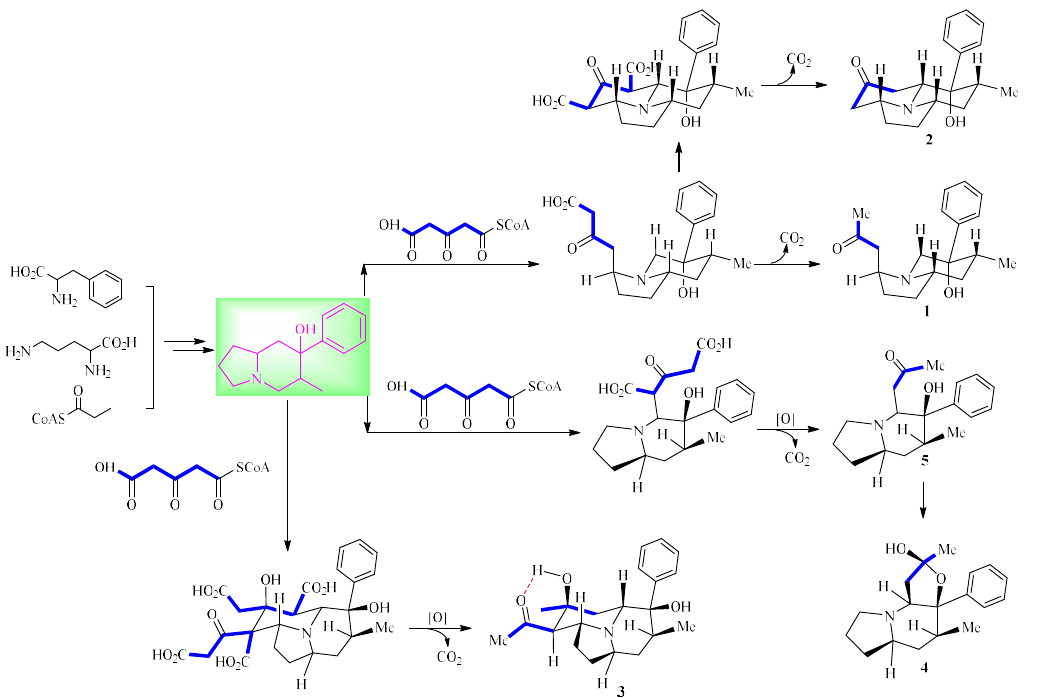
Figure 5. The possible biosynthetic pathway of compounds 1 – 5 .